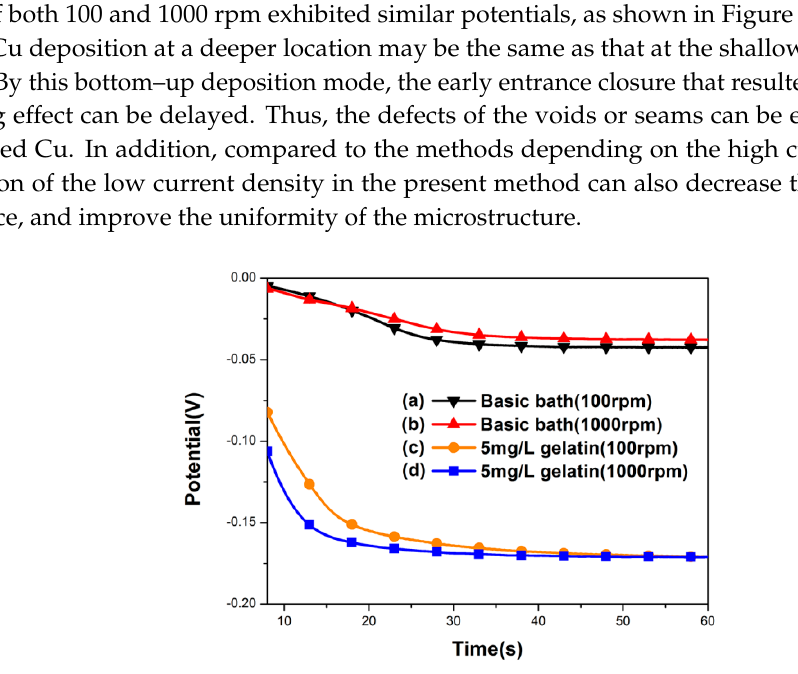
Figure 4. Chronopotentiometry curve for ( a , b ) a basic bath, and ( c , d ) a gelatin-added bath to produce nanotwinned copper with different stirring rates.